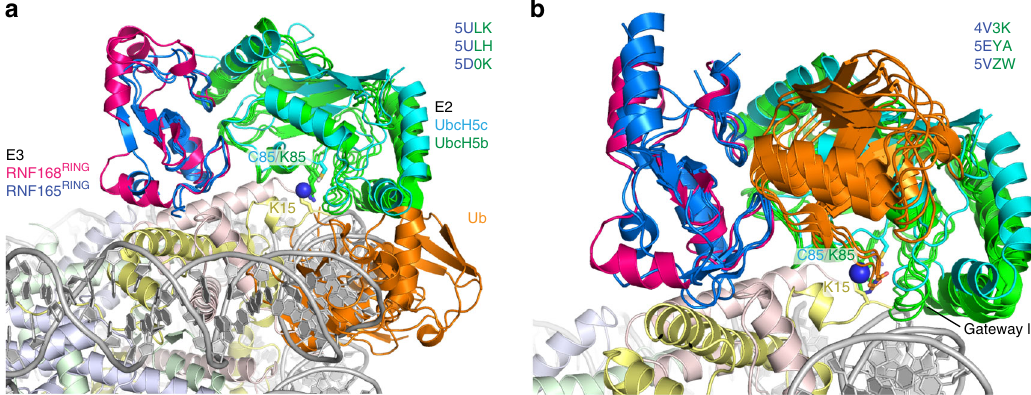
Fig. 5 The nucleosome promotes active, closed E3-E2~Ub conformations. a Superposition of E3-E2~Ub structures in the open state with E3 RNF165 and the E2-E3-nucleosome model for RNF168 indicates that nucleosome surface clashes with such open states. b Superposition of RING E3-E2~Ub structures and the E2-E3-nucleosome model for RNF168 shows that the model is compatible with the closed state of the E3-E2~Ub complex. There are no direct interactions between the nucleosome surface and Ub. Target lysine, here labeled as K15, catalytic center, and gateway loop are indicated. Color coding indicated in the